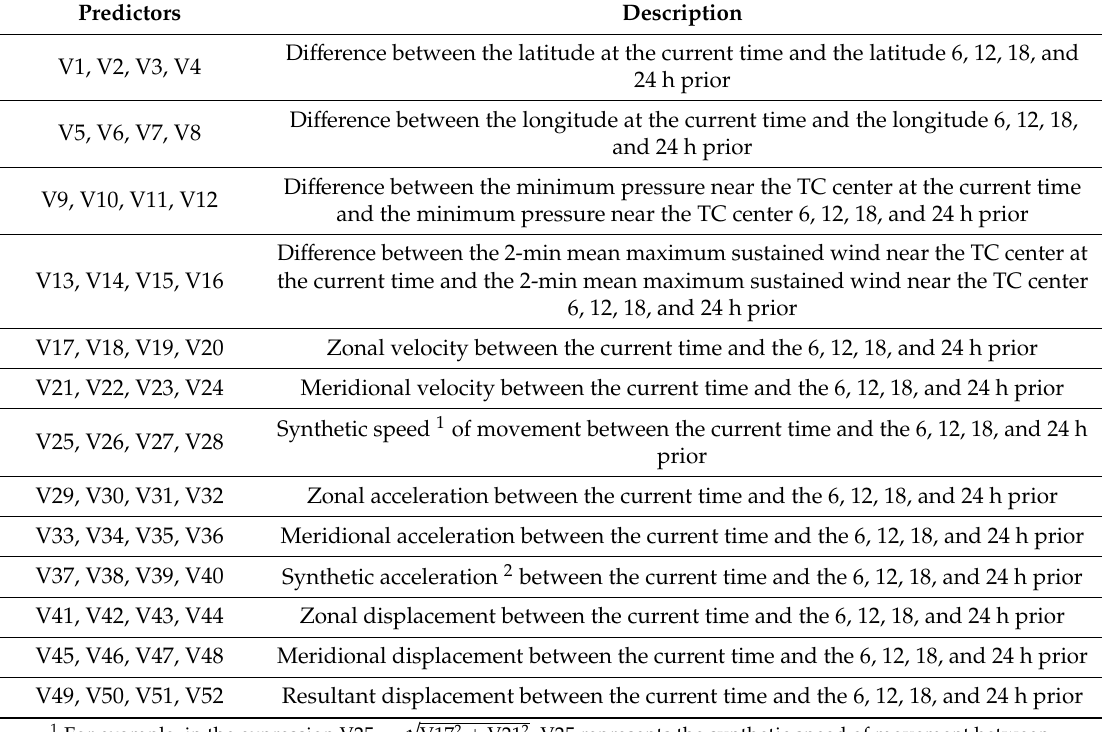
Table 3. Detailed description of the 52 climatology